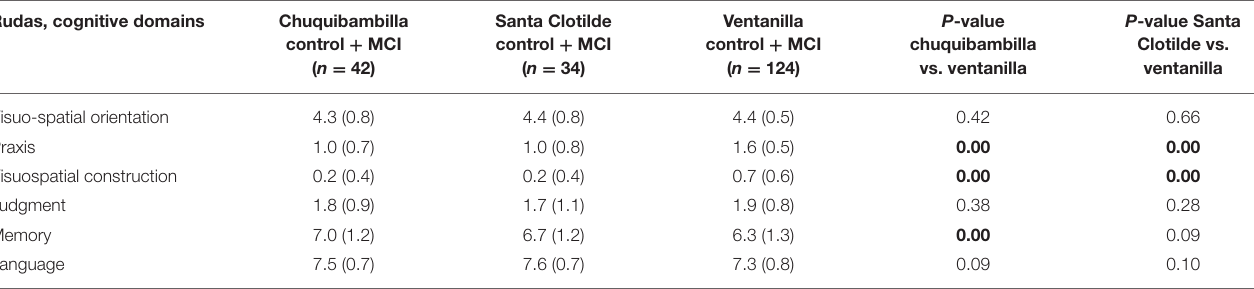
TABLE 2 | Performance on the Peruvian version of the Rowland Universal Dementia Assessment Scale (RUDAS-PE) by cognitive domain among control and MCI groups from rural and urban illiterate Peruvian communities. Rudas, cognitive domains